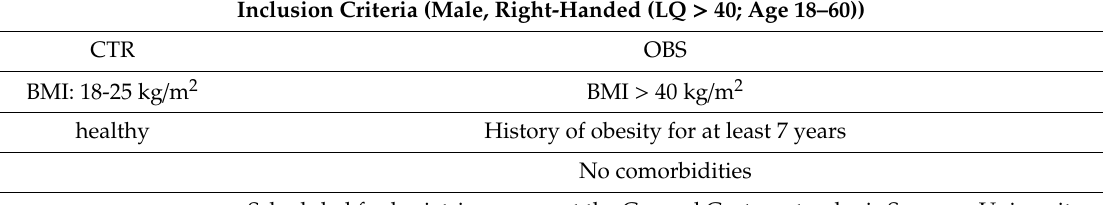
Table 1. Inclusion criteria of enrolled subjects, obese (OBS) vs. controls (CTR). LQ (Laterality Quotient). BMI (Body Mass Index).